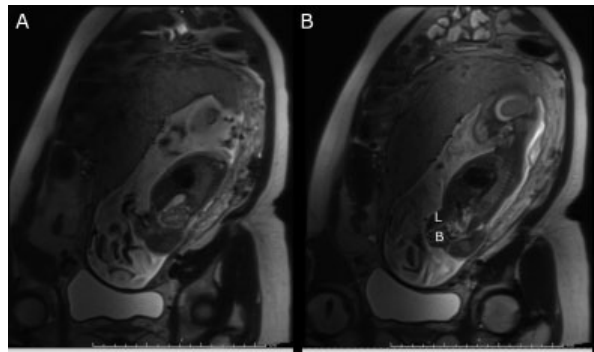
Fig. 1 Prenatal MRI demonstrating omphalocele containing liver (L) and bowel (B), absent bladder, and terminal myelocystocele (not pictured on these slices). MRI, magnetic resonance imaging.